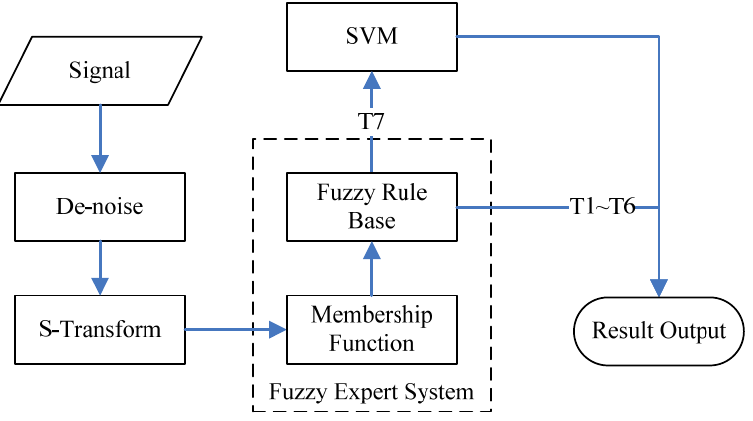
Figure 10. Block diagram of over-voltage identification